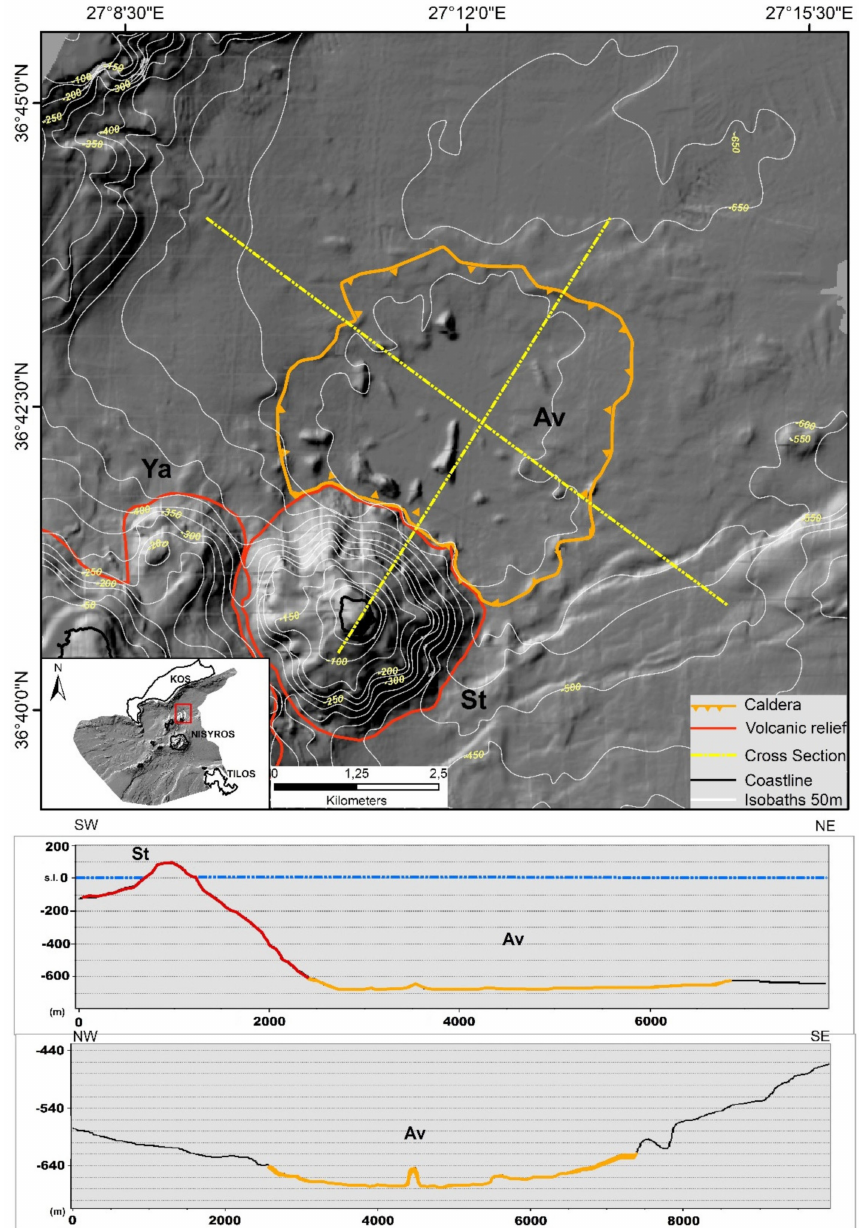
Figure 8. The slightly asymmetric circular Avyssos (Av) caldera at the southern part of the Eastern Kos Basin is characterized by a nearly horizontal planar floor according to the topographic profiles. The volcanic relief of Strongyli (St) and Avyssos (Av) submarine caldera are depicted in topographic profiles. Ya: Yali